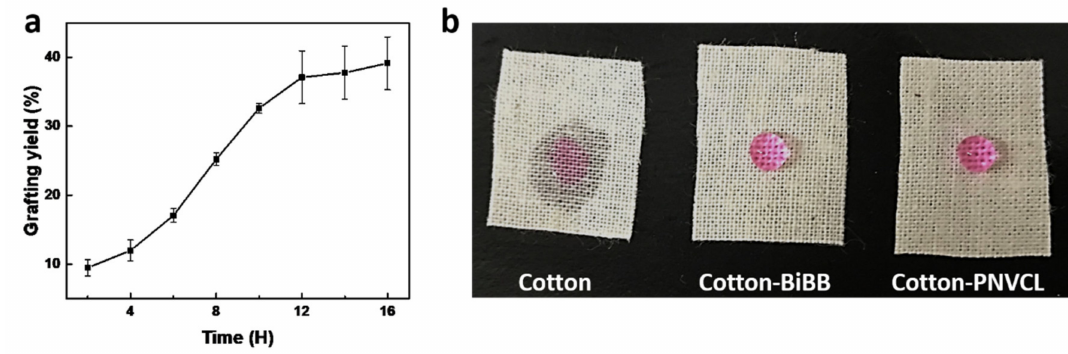
Figure 2. ( a ) Grafting yield of PNVCL grafted onto pure cotton, plotted with respect to the polymerization reaction time. ( b ) Photograph of samples of cotton, cotton- α -bromoisobutyryl bromide (cotton-BiBB), and cotton-PNVCL fabrics treated with a water drop, revealing the di ff erences in hydrophobicity before and after polymer grafting.